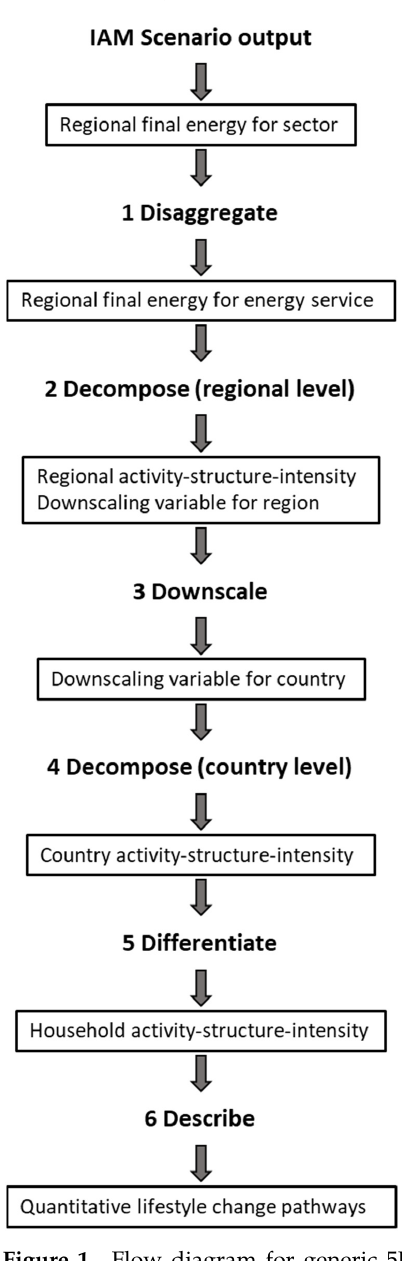
Figure 1. Flow diagram for generic 5Ds method . Initial scenario output from global IAMs is from publicly available repositories. Subsequent calculation steps are carried out for target year. Information passed from one step to the next is shown in boxes.